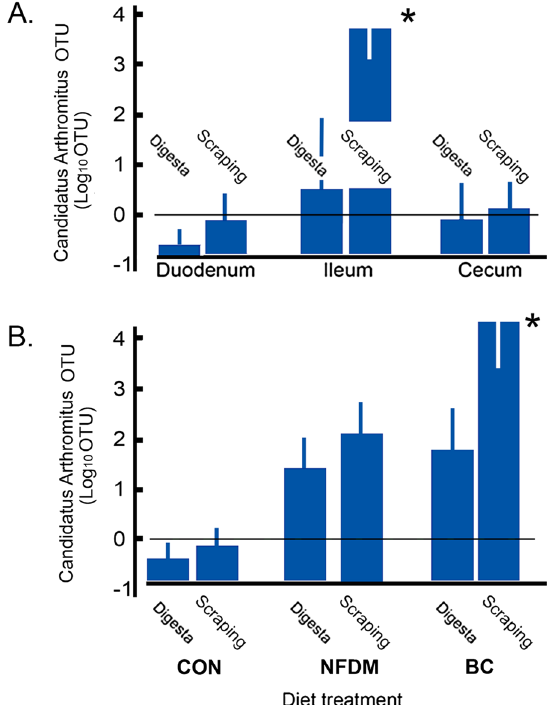
Fig. 6 Candidatus Arthromitus is present in the ileal scraping and increased by BC. Mean ( SEM) abundance of Candidatus ± Arthromitus represented as Log10 [OTU] in the three different segments of the gut and further differentiated by digesta vs. scraping (Panel A ). Mean ( SEM) abundance of Candidatus Arthromitus ± represented as Log10 [OTU] in the ileum as measured in digesta or cell scrapings (attached) as affected by diet. * P < 0.04 (Panel B )